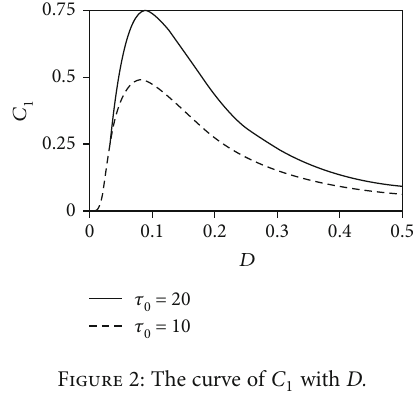
Figure 2: The curve of C